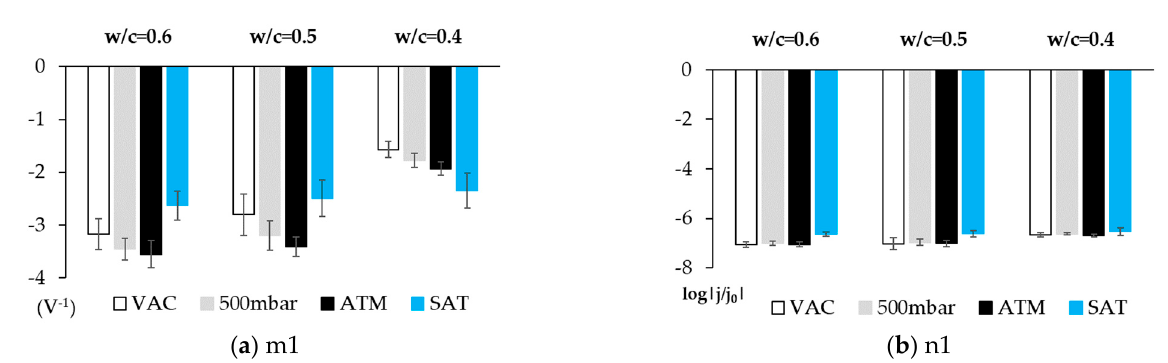
Figure 11. Average value of the slope (m1) and intercept (n1) of lines 1 and 2 for each studied dosage and each state. ( a ) Data of the slope of line 1 (m1). ( b ) Data of the intercept of line 1 (n1).